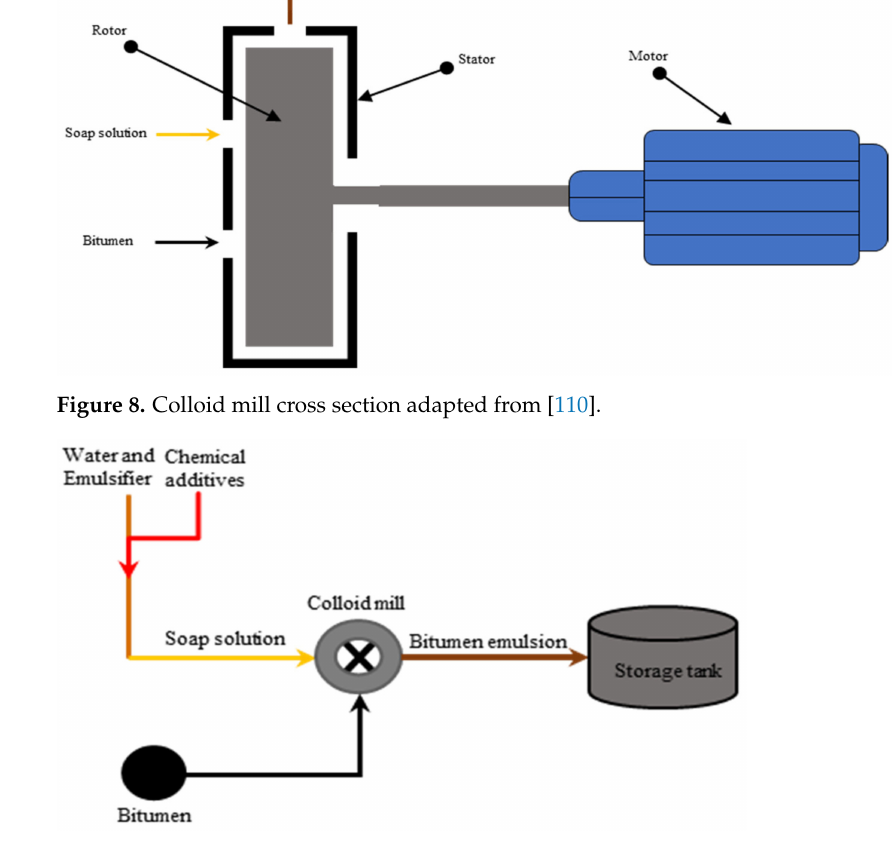
Figure 9. Schematic of a bitumen emulsion plant adapted from